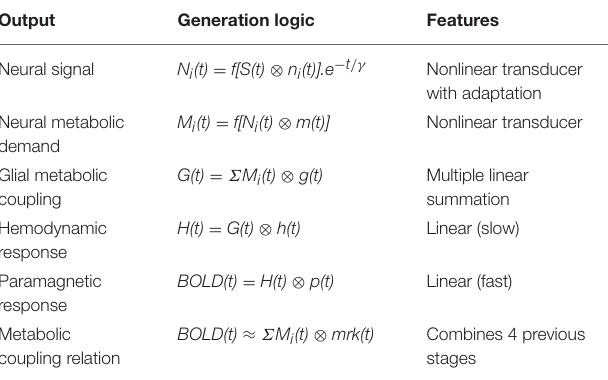
TABLE 1 | Mathematical model of the operations involved in the generation of the BOLD signal from the input stimulus. Output